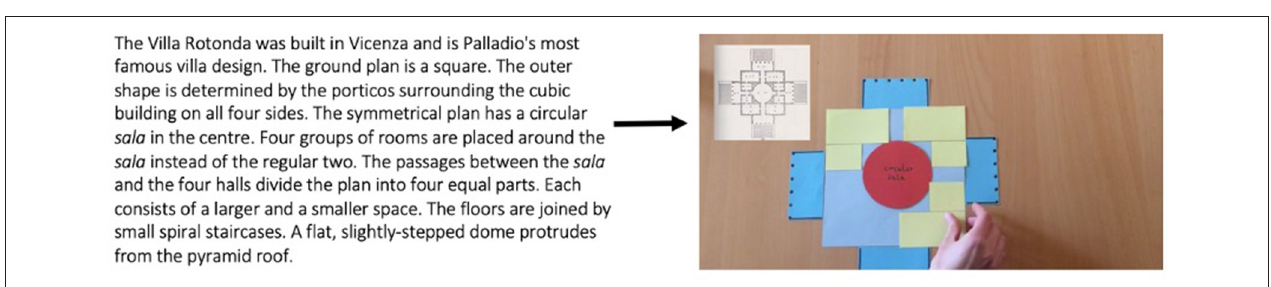
FIGURE 9 | Transducing a segment of narration to Model 4.